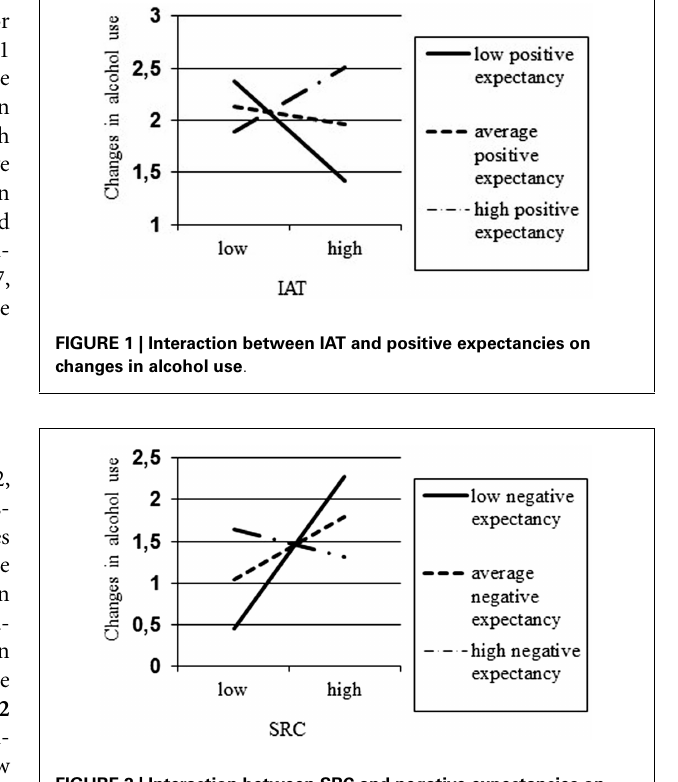
FIGURE 2 | Interaction between SRC and negative expectancies on changes in alcohol use